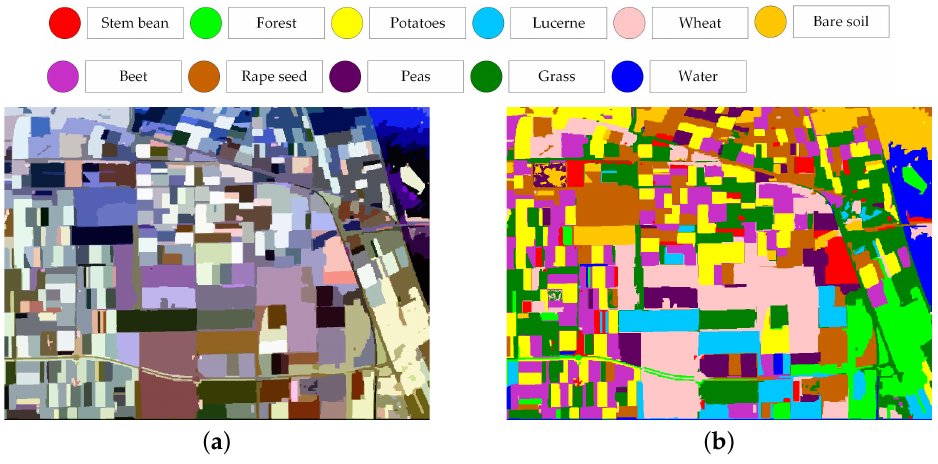
Figure 21. Final classification map of AIRSAR Flevoland data set. ( a ) Superpixels generated by SRM. ( b ) Final classification